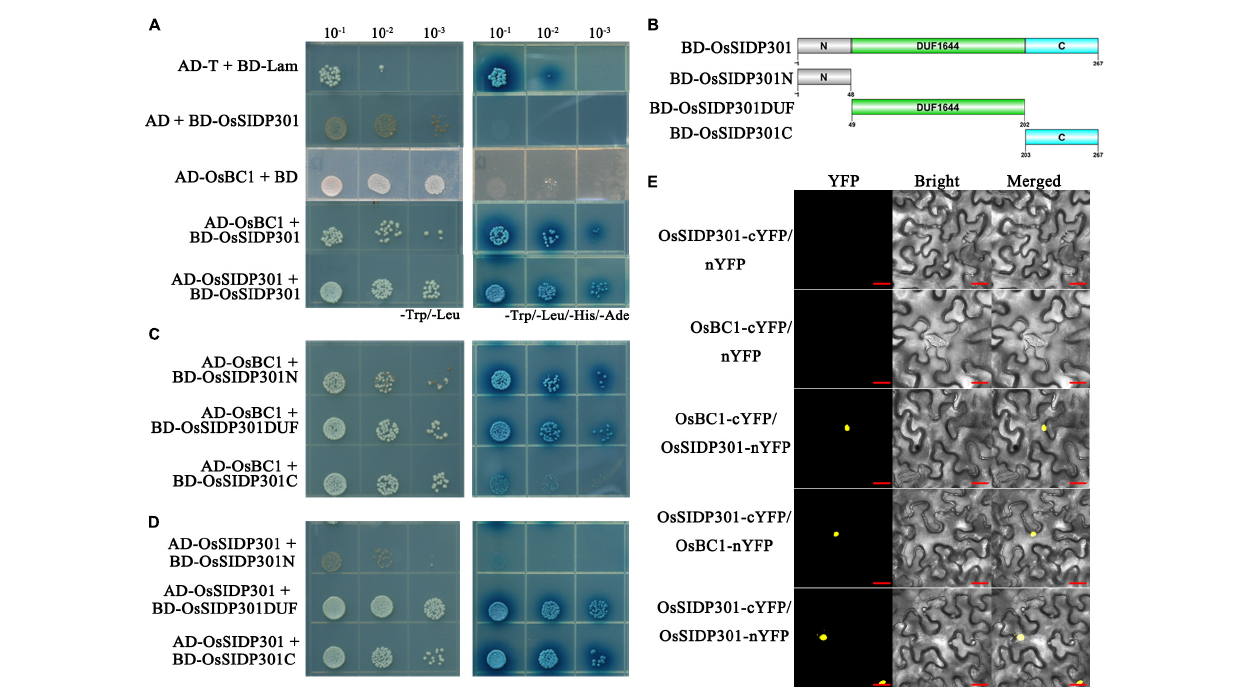
FIGURE 9 | OsSIDP301 interacts with OsBC1. Yeast two-hybrid assay demonstrated the OsSIDP301 interacts with OsBC1 (C) and itself (D) by the full length (A) , N terminal, the DUF1644 domain, and the C terminal of OsSIDP301, respectively. (B) The protein truncation sites of OsSIDP301. (E) BiFC assay demonstrated the OsSIDP301 interacts with OsBC1 in vivo , the YFP fluorescence signals located in nuclear of N. benthamiana leaves, bar = 20 µ m.